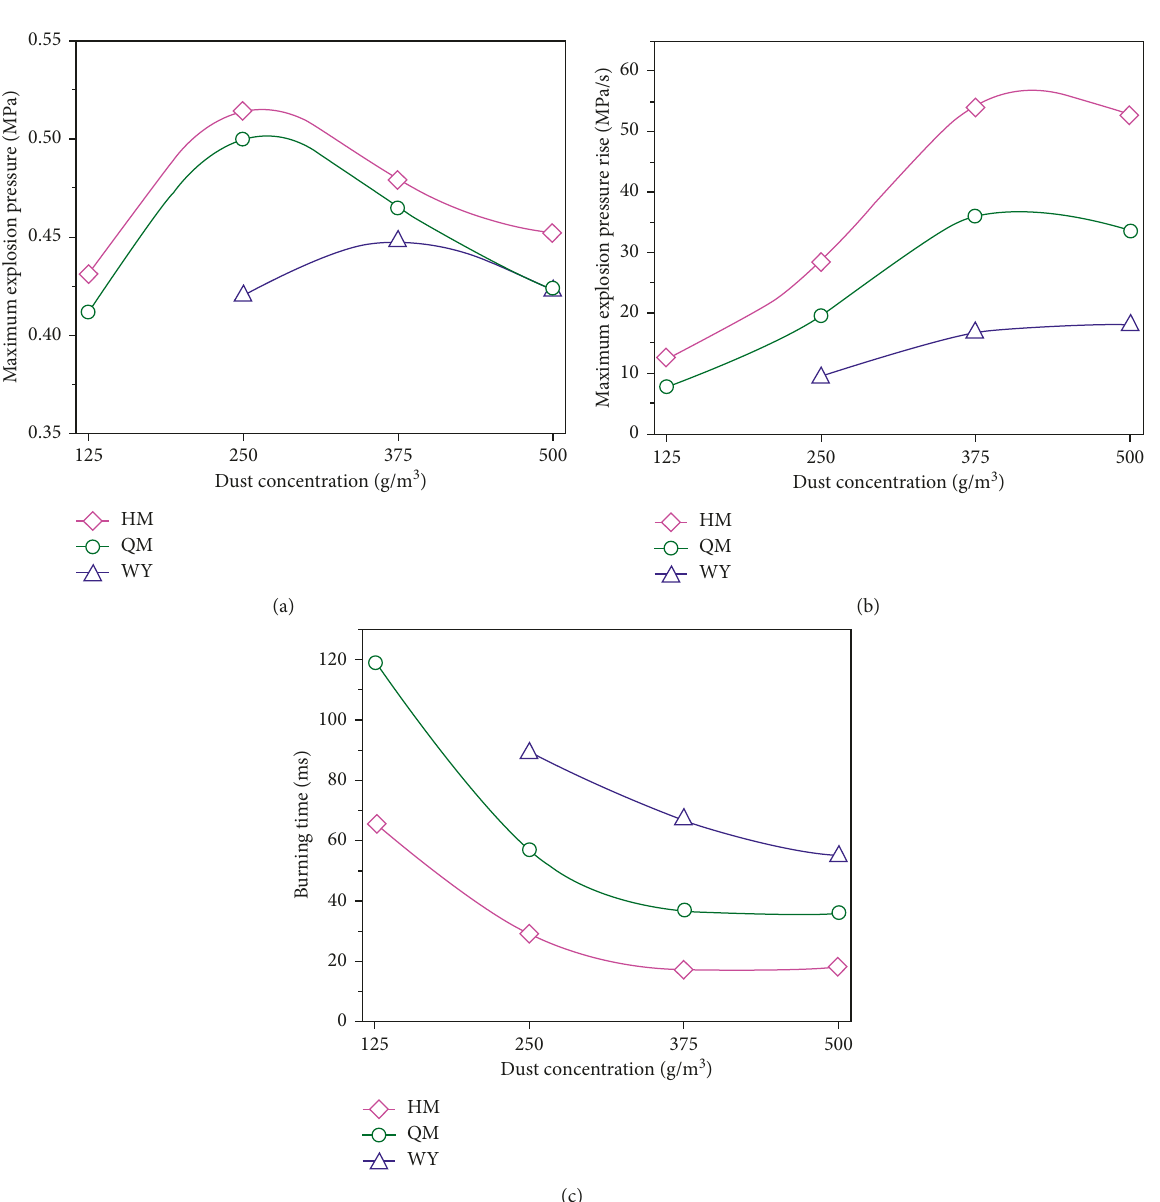
Figure 7: P , (d P /d t ) max , and t b of the three coal dust under different concentrations: (a) HM; (b) QM; (c) max